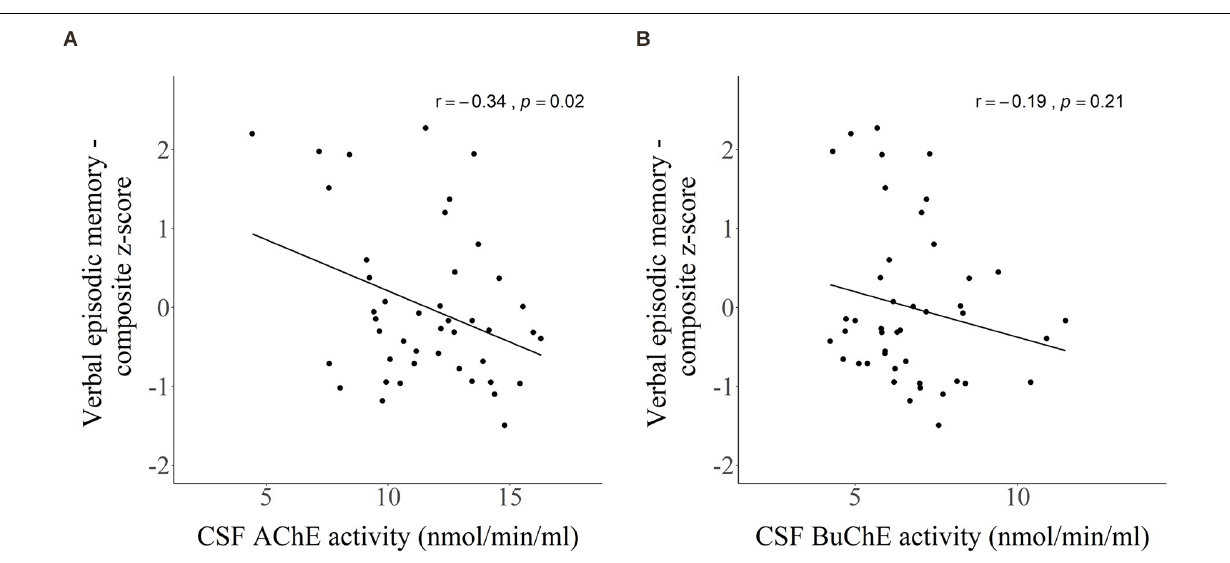
FIGURE 6 | Scatter plots presenting Pearson’s correlations between CSF activity of (A) AChE and (B) BuChE with composite z -score of verbal episodic